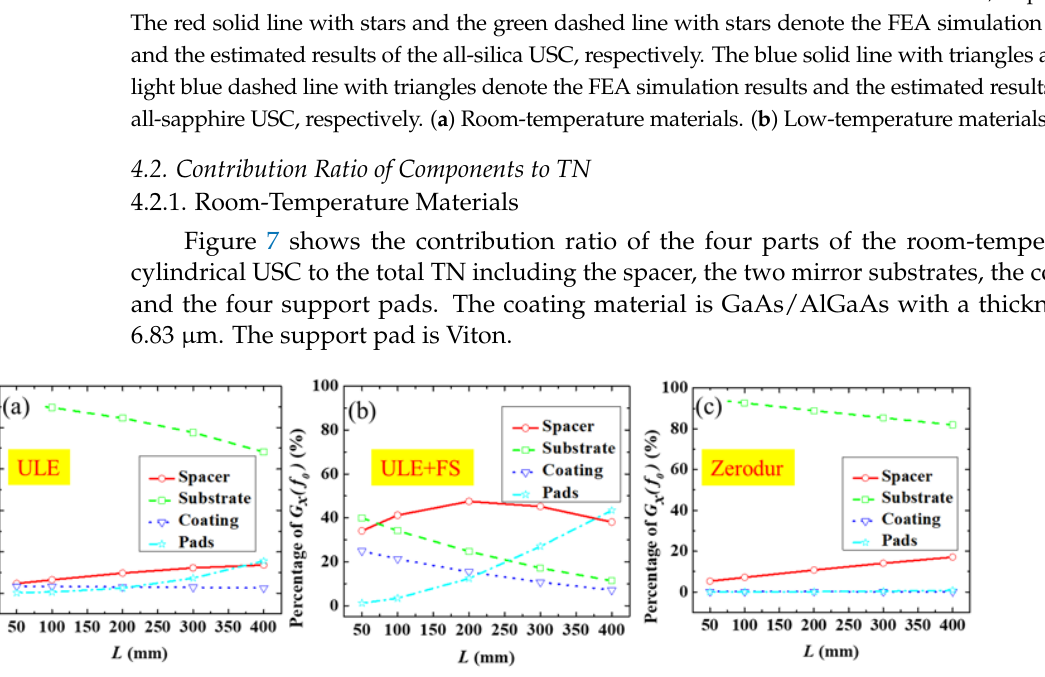
Figure 7. Percentage of contributions to the TN of the optical length Gx(f 0 ) as functions of the length L . The coating is GaAs/AlGaAs crystalline with the thickness d coa = 6.83 μ m cited from ref. [19]. The solid red line with circles denotes the spacer results. The dashed green line with squares denotes the substrate results. The dot blue line with triangles denotes the coating results. The dash–dot cyan line with stars denotes the four support pads’ results. ( a ) All ‐ ULE USC. ( b ) ULE spacer and FS substrates. ( c ) All ‐ zerodur USC.